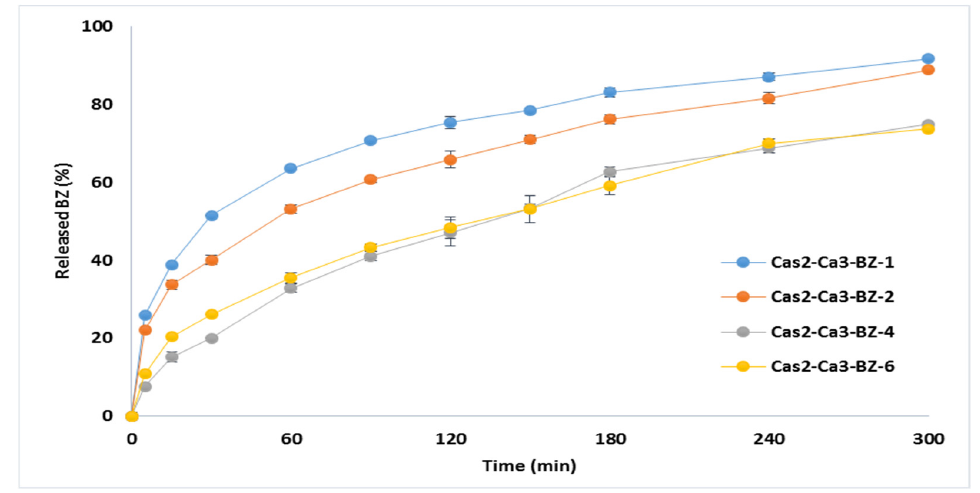
Figure 7. In vitro BZ release from spray dried casein nanoparticles prepared at different poly- mer/drug ratios (n = 3).